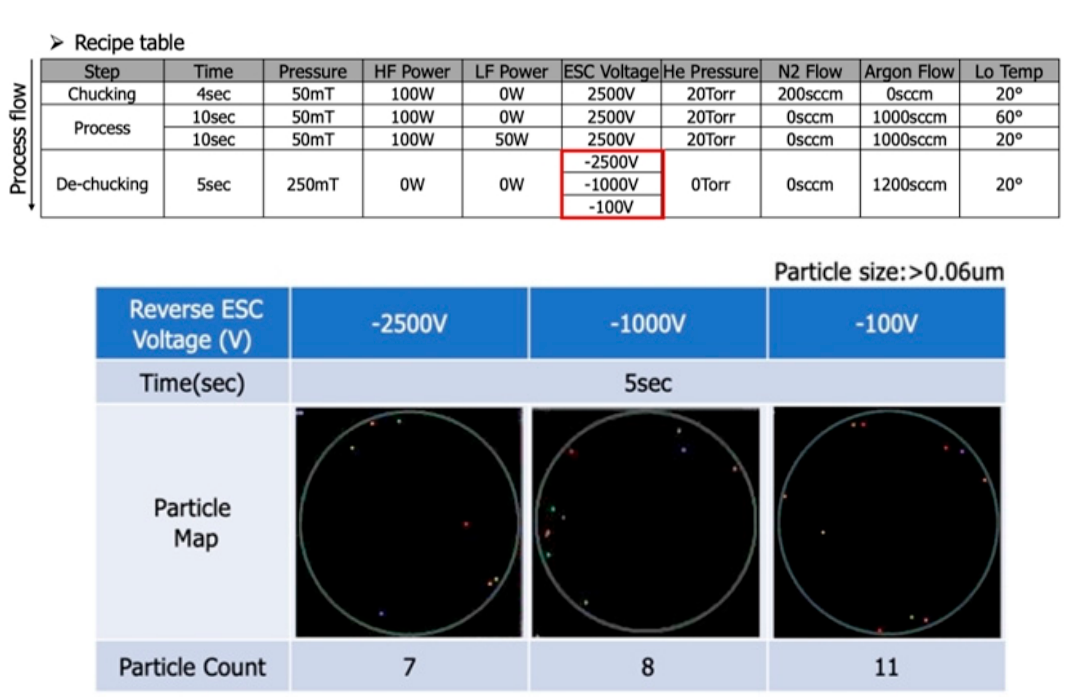
Figure 19. Particle deposition results under different application times for an ESC reverse voltage.